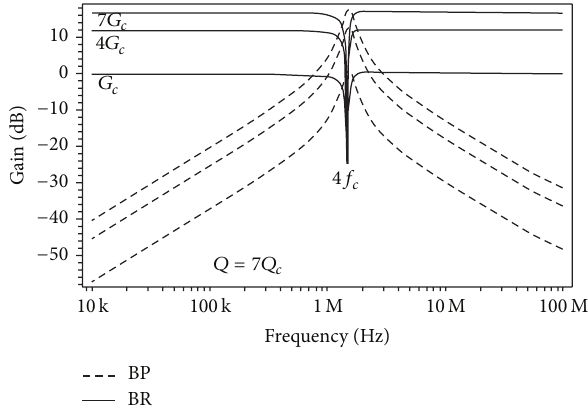
Figure 11: Gain programming of BP and BR.